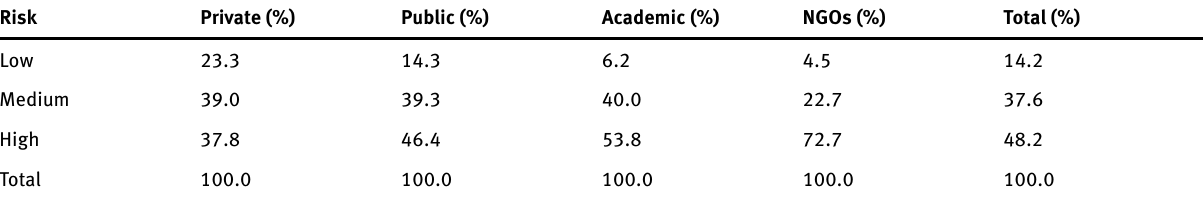
Table 3: The potential risk perception of the biobased economy’s expansion, by sectors. Risk